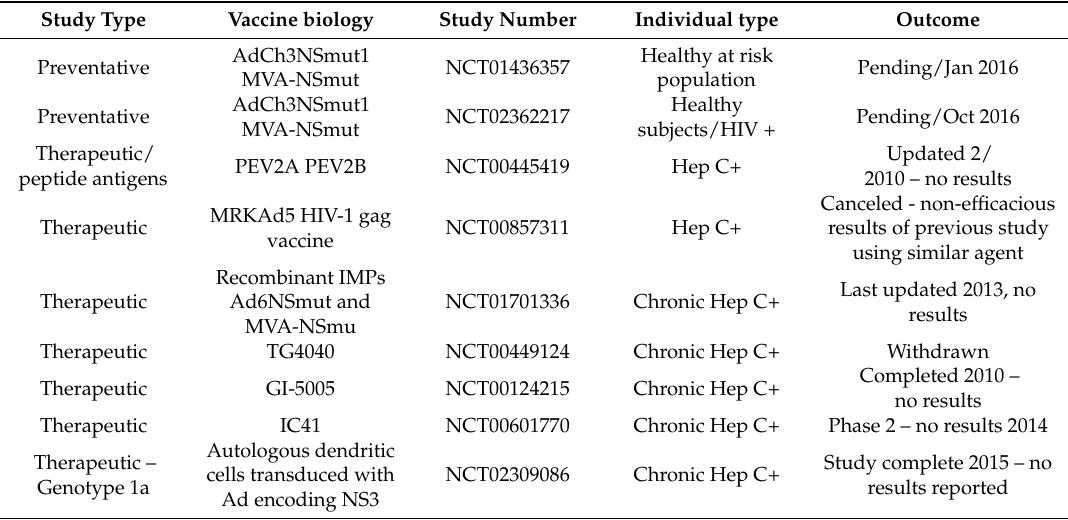
Table 3. Clinical trials in HCV vaccine. All data below obtained from